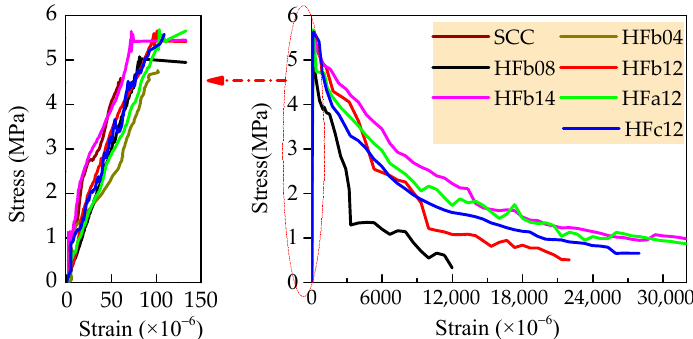
Figure 7. The axial tensile stress-strain curves of self-compacting SFRC.